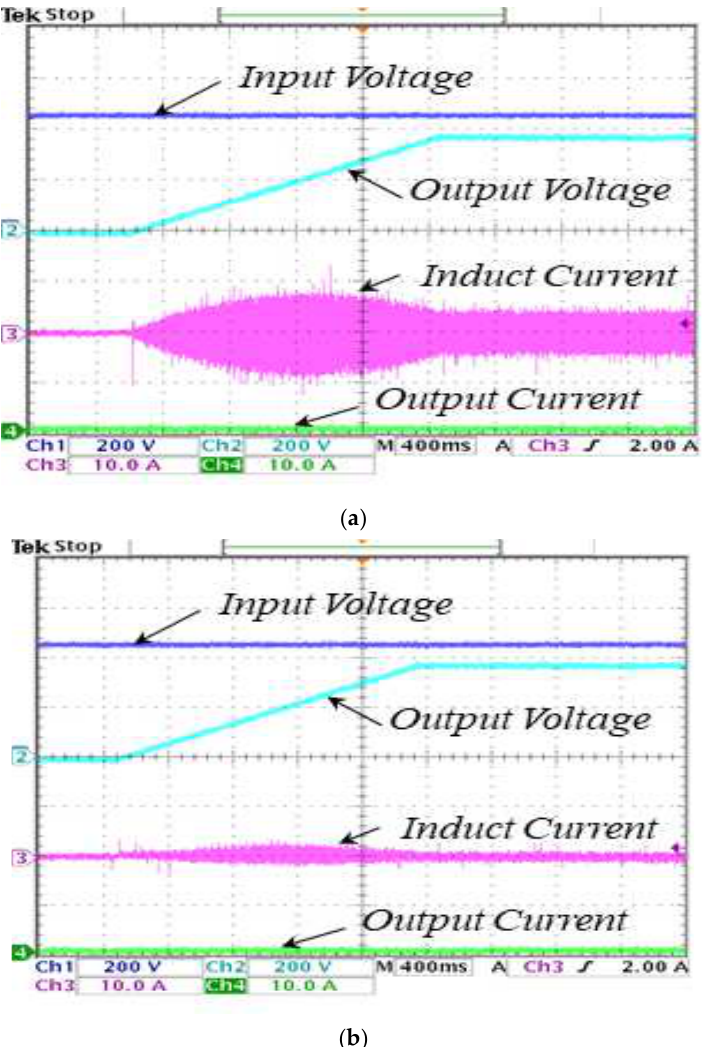
Figure 13. Comparison waveform of no-load starting characteristics. ( a ): Experimental results of conventional converters. ( b ): Experimental results of the proposed converter.